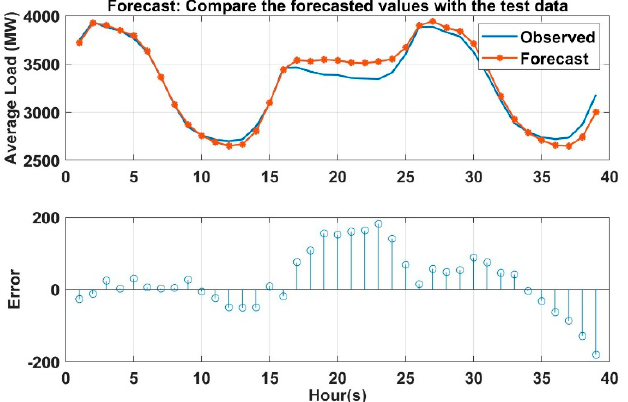
Figure 13. Comparison of per-hour forecast future time series with test data (observed value).